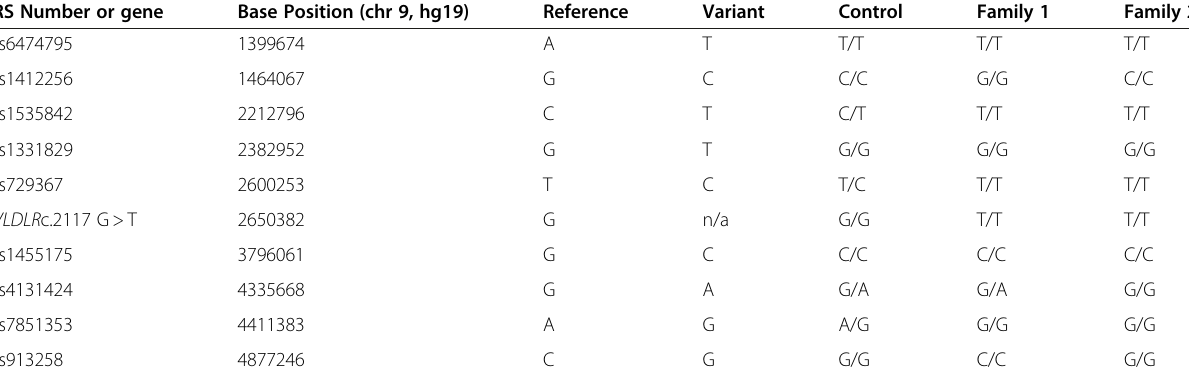
Table 2 Genotyping from Family 1 and Family 2 surrounding the VLDLR mutation suggests a common ~1,500,000 base pair haplotype inherited by affected individuals in both families, between base position chr9:2,212,796